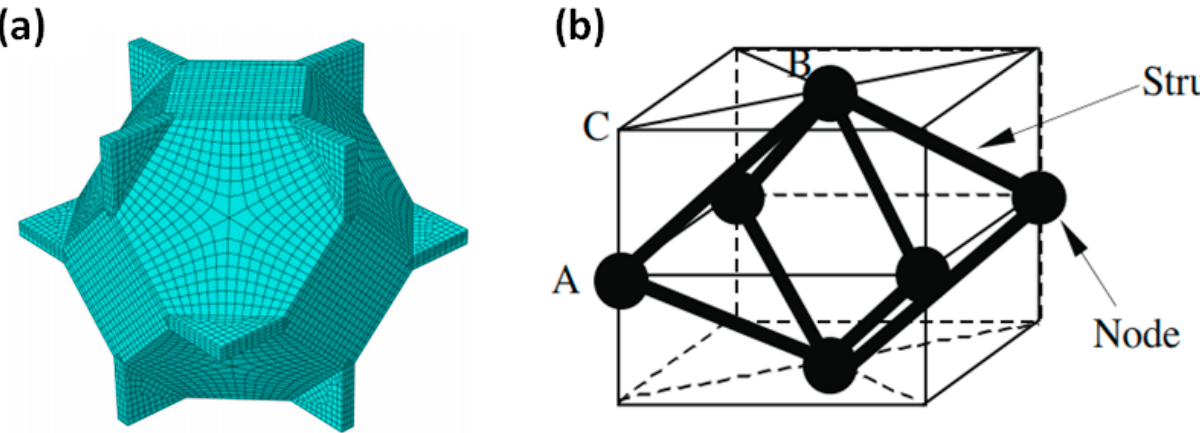
Figure 6. Improved single cell model ( a ) tetradecahedron model (Kelvin model) [115] and ( b ) octahedron model [116].